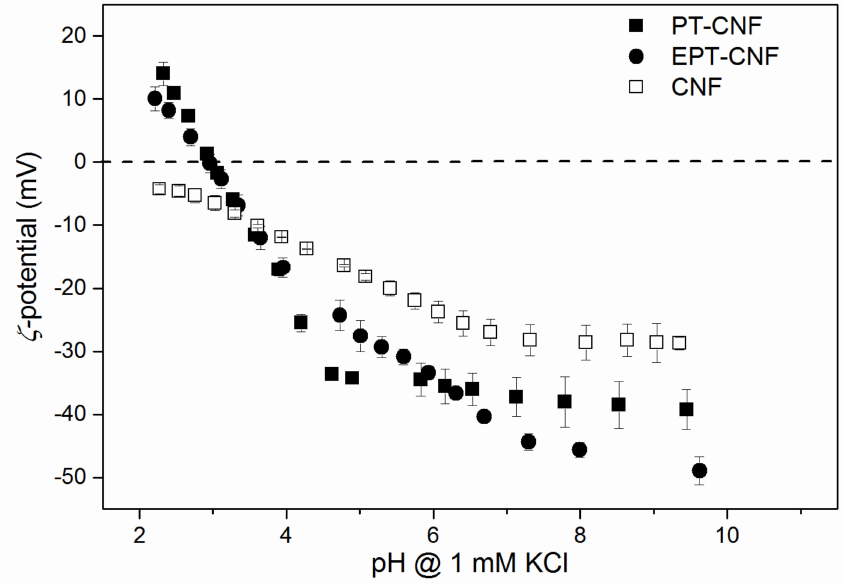
Figure 3. ζ -potential of (black square) PT-CNF, (black dot) EPT-CNF, and (empty square) unmodified nanopapers as a function of